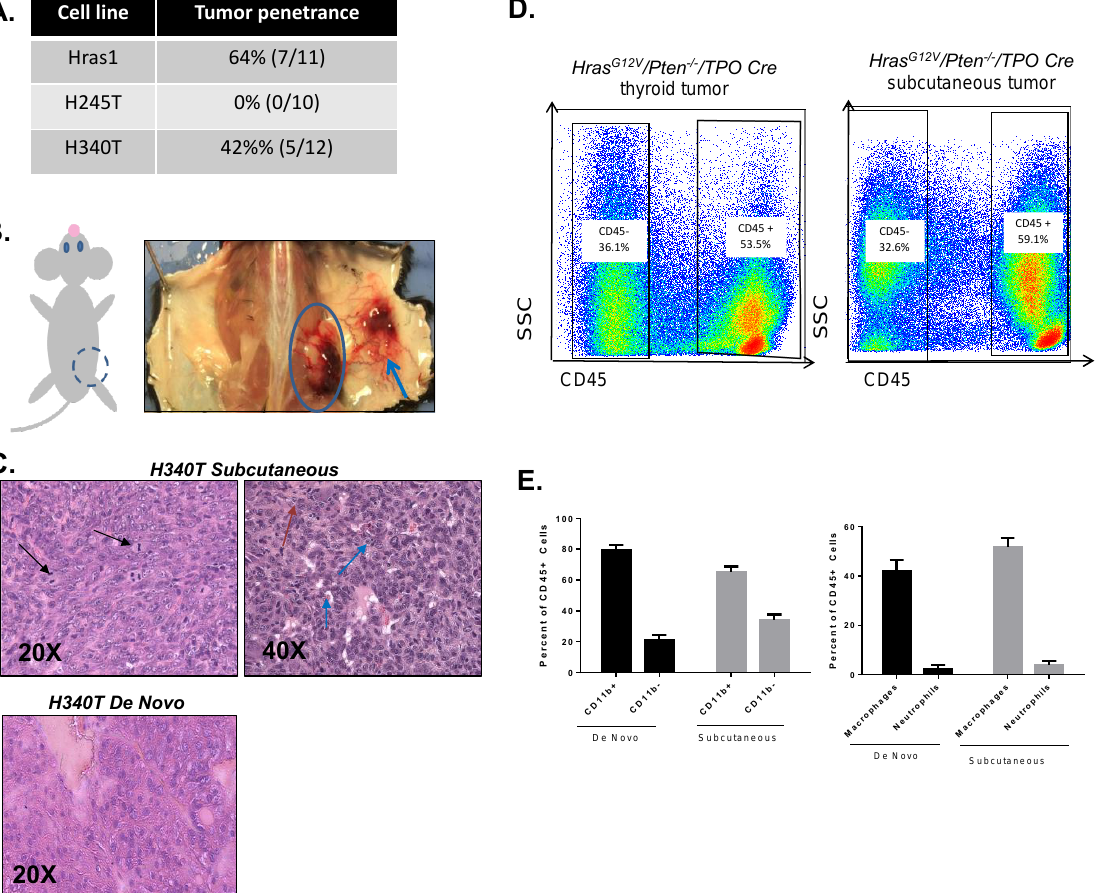
Figure 6. Development of syngeneic tumor model. ( A ) Tumor penetrance rates for all Hras G12V /Pten −/− /TPO-Cre thyroid tumor cell lines (Hras1, H245T, H340T) representing the number of mice with visible or palpable tumors as a percentage of total mice injected. Mice were monitored for 15 weeks, at which point all were sacrificed. Subcutaneous injections were repeated at least three times with each experiment including ten or more recipient mice ( n = 10–12). ( B ) Gross image of subcutaneous tumor (blue circle) and neovascularization (arrow) on the right hind flank of a wild-type (WT) recipient in comparison to the control contralateral hind flank. ( C ) H&E staining of subcutaneous tumor sections derived from subcutaneous Hras G12V /Pten −/− /TPO-Cre thyroid tumor cells (H340T). Subcutaneous tumors were poorly differentiated or anaplastic with multiple mitotic cells ( top left, black arrows ) in addition to nuclear vesicular changes ( top right, red arrow ) and prominent nucleoli ( top right, blue arrows ). In contrast to H340 source tumor (bottom), subcutaneous tumors demonstrated complete loss of normal follicular pattern. ( D ) Representative FACS analysis of CD45+ immune cell population in de novo Hras G12V /Pten −/− /TPO-Cre thyroid tumor (left) and subcutaneous tumor (right) derived from an Hras G12V /Pten −/− /TPO-Cre cell line (H340T). Original blots see Figure S1 ( E ) FACS analysis of immune cells within the TME of de novo Hras G12V /Pten −/− /TPO-Cre tumors and subcutaneous tumors derived from H340T. Results demonstrate both models are enriched with cells of the myeloid lineage (CD11b+, left ). Within the myeloid lineage, macrophages represent the largest percentage of cells in the TME ( right ) All groups were compared via two-way ANOVA with Sidak test for multiple comparisons. No statistically significant differences between models were detected.